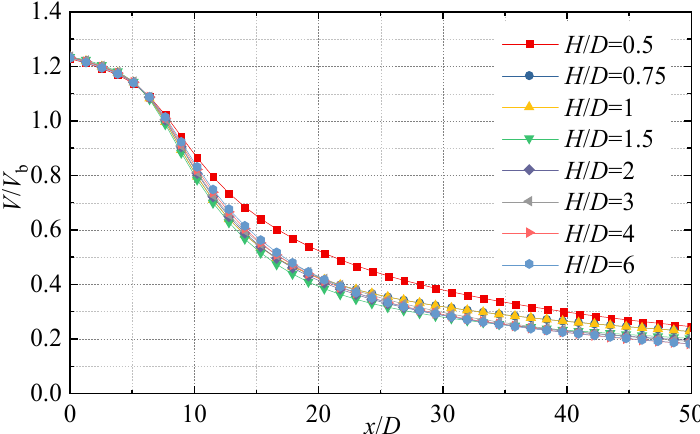
Figure 11. Distribution of horizontal jet axial dimensionless velocity V / V b at different horizontal heights.